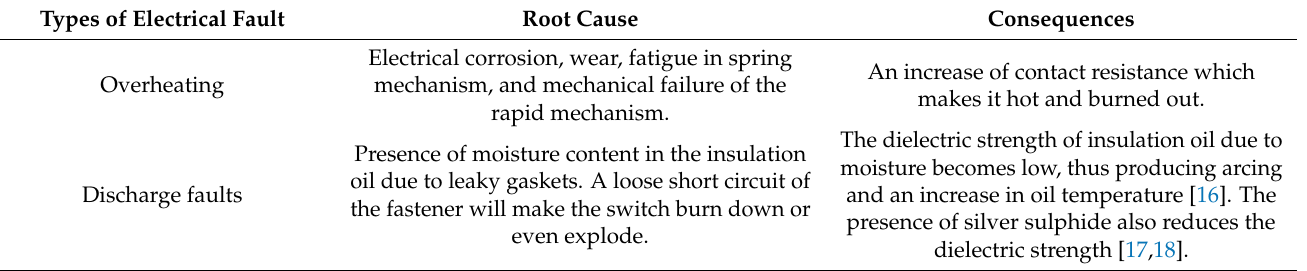
Table 3. Common electrical faults in OLTCs [10].